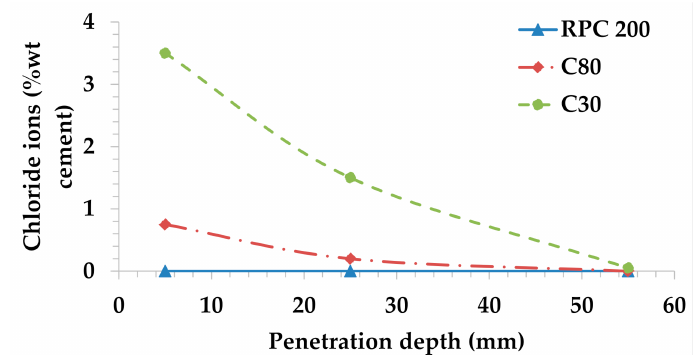
Figure 2. Chloride penetration profile in C30, C80, and RPC200